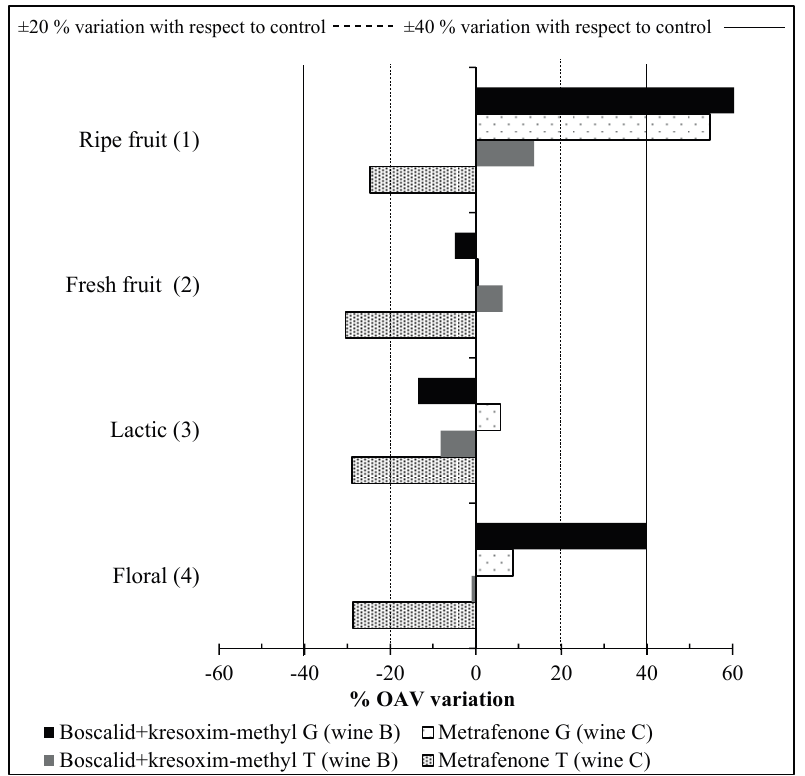
Figure 3. Percentages of variation with respect to the control wine on the OAV of monovarietal red wines (G, Graciano; T, Tempranillo) by effect of boscalid + kresoxim-methyl and metrafenone (in brackets the number of the odorant series as reported in Table